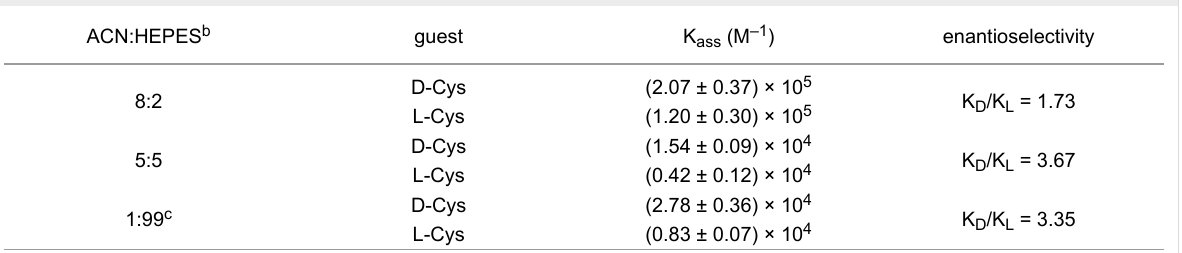
Table 2: Association constants K ass (M –1 ) of Cd 2+ – ACAQ a with antipodal Cys in different solvents.